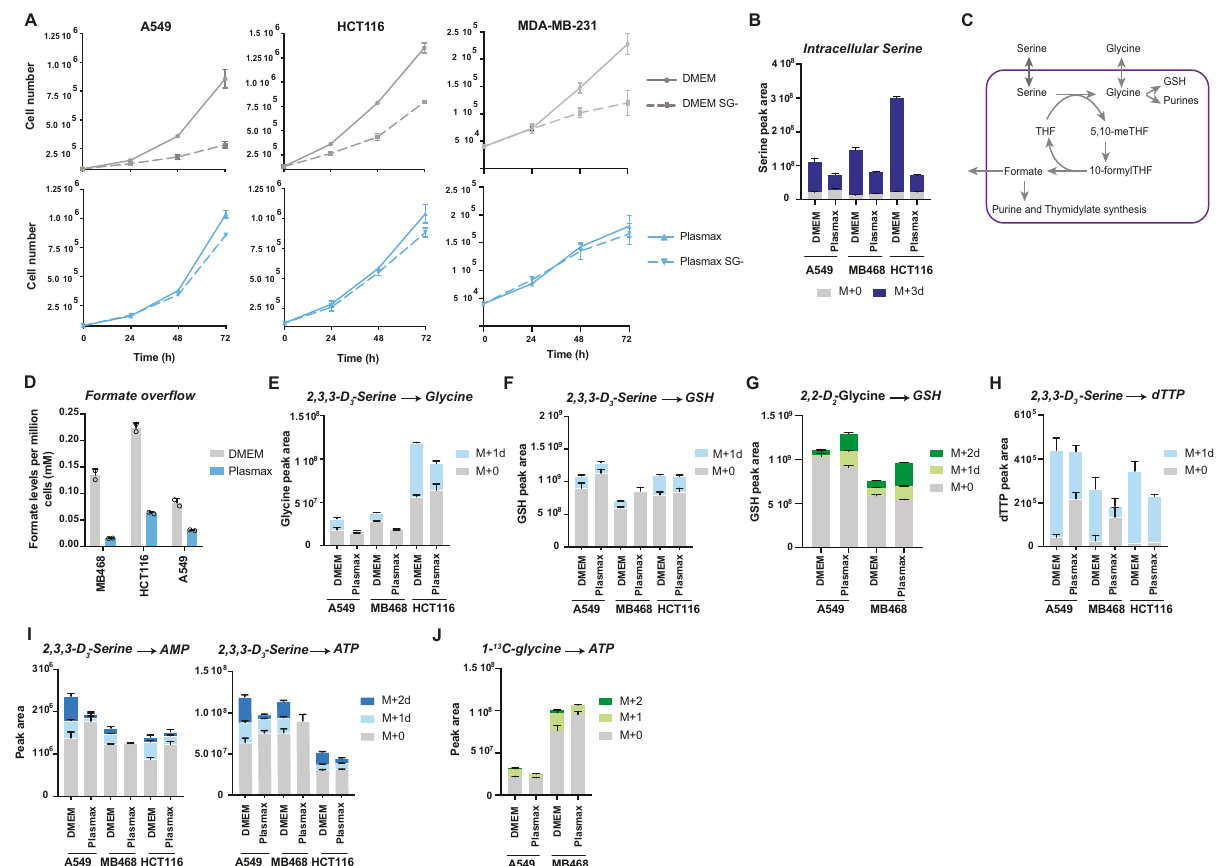
Fig. 1 Serine and glycine metabolism in Plasmax. A Growth curve of A459, HCT116 and MDA-MB-231 grown in DMEM and Plasmax with or without serine/ glycine (SG-). Data are represented as mean±SD of triplicate wells. B Intracellular levels of serine measured by LC – MS after incubation with 400 µ M or 140 µ M of 2,3,3-D 3 -Serine in DMEM and Plasmax, respectively. Data are represented as mean±SD of triplicate wells. C Serine is converted by the SHMT enzymes into glycine which will contribute to a number of important processes such as redox defence, nucleotide production and provision of one-carbon units to the folate cycle and methylation reactions. D Extracellular formate measured after 72h in DMEM (grey) and Plasmax (blue) by NMR. Data are represented as mean±SD of duplicate wells. E Intracellular levels of glycine measured by LC – MS after 4h incubation with 400 µ M or 140 µ M of 2,3,3-D 3 -Serine in DMEM or Plasmax, respectively. Data are represented as mean±SD of triplicate wells. F Intracellular levels of GSH measured by LC – MS after 4h incubation with 400 µ M or 140 µ M of 2,3,3-D 3 -Serine in DMEM or Plasmax, respectively. Data are represented as mean±SD of triplicate wells. G Intracellular levels of GSH measured by LC – MS after 4h incubation with 400 µ M or 330 µ M of 2,2-D 2 -Glycine in DMEM or Plasmax, respectively. Data are represented as mean±SD of triplicate wells. H Intracellular levels of dTTP measured by LC – MS after 4h incubation with 400 µ M or 140 µ M of 2,3,3-D 3 -Serine in DMEM or Plasmax, respectively. Data are represented as mean±SD of triplicate wells. I Intracellular levels of AMP and ATP measured by LC – MS after 4h incubation with 400 µ M or 140 µ M of 2,3,3-D 3 -serine in DMEM or Plasmax, respectively. Data are represented as mean±SD of triplicate wells. J Intracellular levels of ATP measured by LC – MS after 4h incubation with 400 µ M or 330 µ M of 1- 13 C-glycine in DMEM or Plasmax, respectively. Data are represented as mean±SD of triplicate wells. All graphs are representative of 3 independent experiments. Source data are provided as a Source Data fi